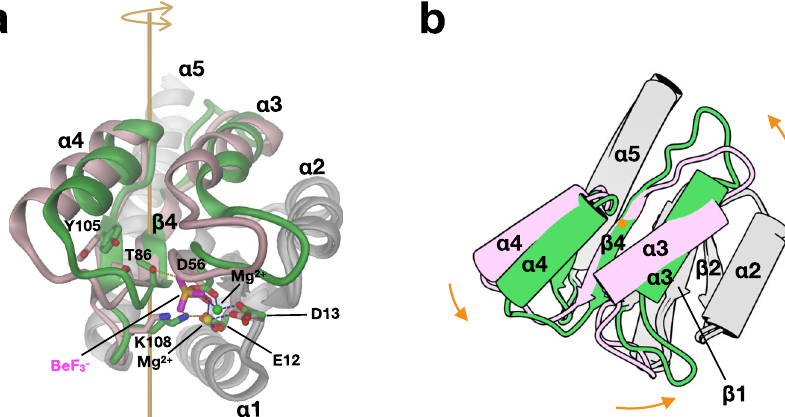
Fig. 3 Beryllo fl uoride modi fi cation induces a relative 16 ̊ rotation of two Rec halves. Rigid-body 1 composed of α 3, β 4, α 4, β 5 (shown in pink and green for DgcR ’ and DgcR ’ *, respectively) is rotated with respect to the rest (rigid-body 2, grey) as seen after super-postion of the two grey substructures. a Native and activated Rec domains with important residues shown in full viewed perpendicularly to the rotation axis of the relative rotation (orange). In DgcR ’ *, the beryllo fl uoride group forms an H-bond with T86 and an ionic interaction with K108 of DgcR ’ *. b Same as a , but in cartoon representation and viewed along rotation